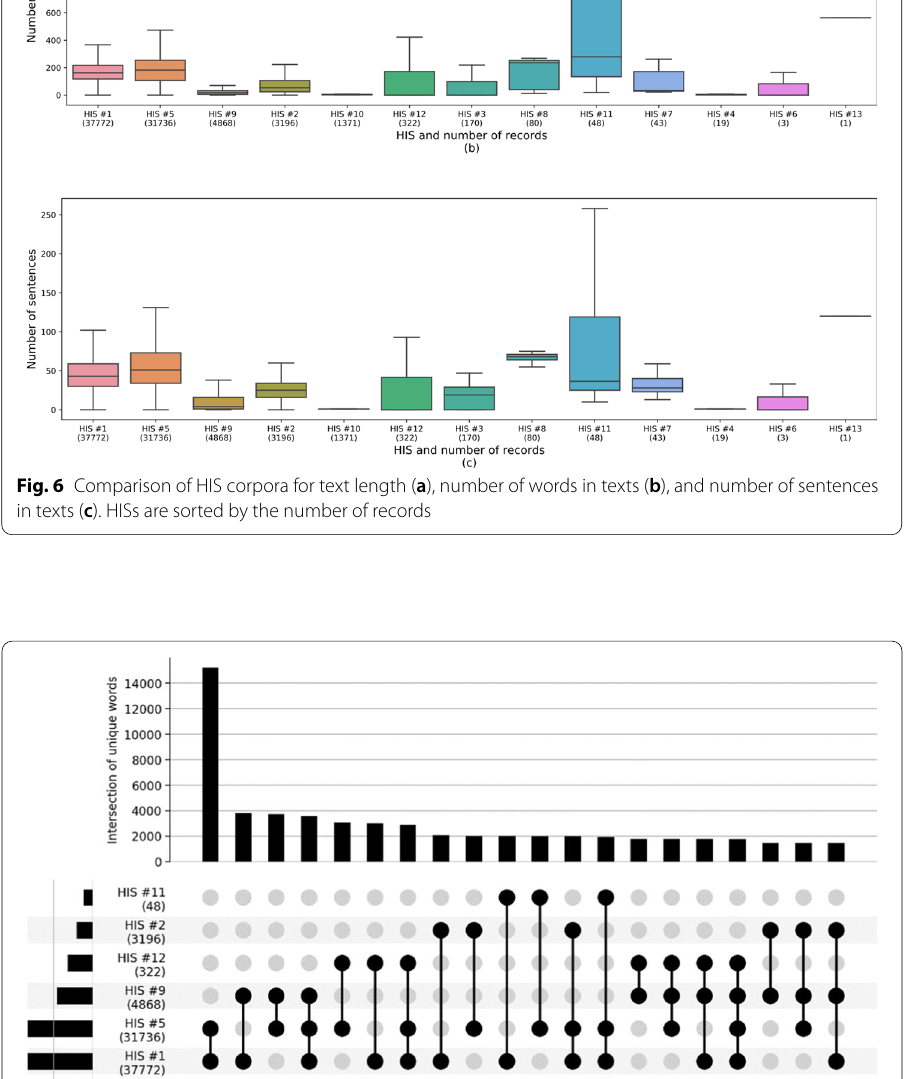
Fig. 7 Upset plot for the most common intersections of unique words of